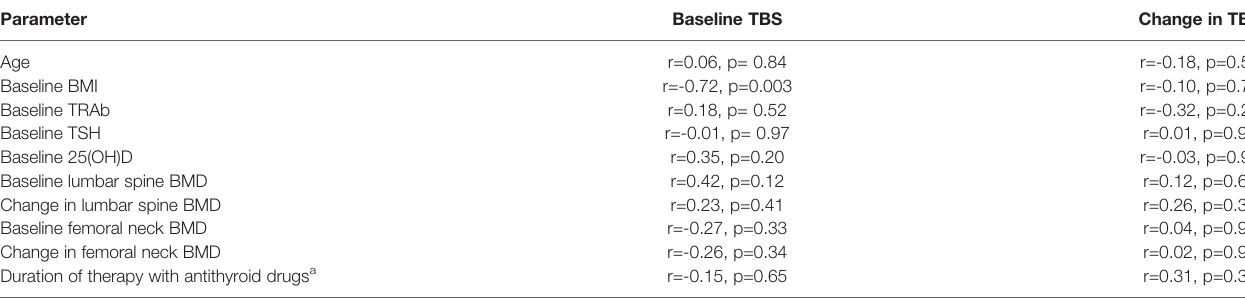
TABLE 3 | Correlations between the baseline trabecular bone score (TBS) and change in TBS with selected parameters.